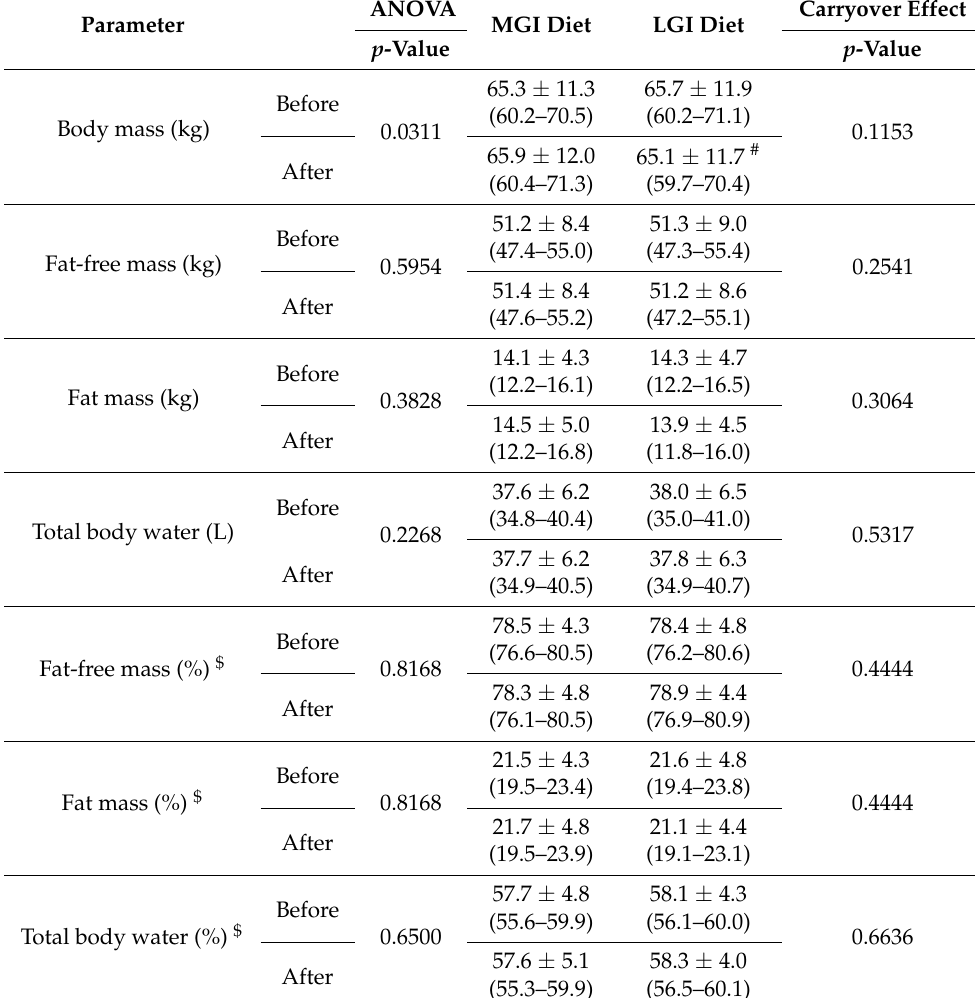
Table 2. Body mass and body composition before and after the three-week MGI and LGI